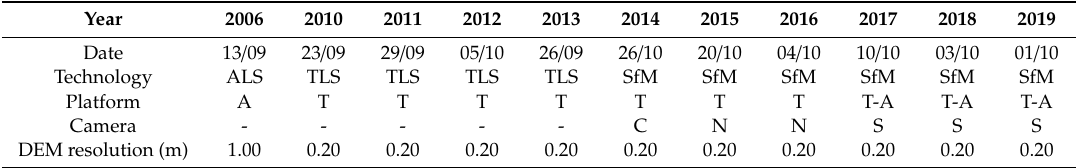
Table 1. Main characteristics of topographic surveys used in this study. Survey technology: ALS = Aerial Laser Scanning, TLS = Terrestrial Laser Scanning, SfM = Structure from Motion. Platform: T = terrestrial, A = aerial. Camera type: C = Canon EOS 5D Mark III, N = NIKON D5100, S = Sony Alpha